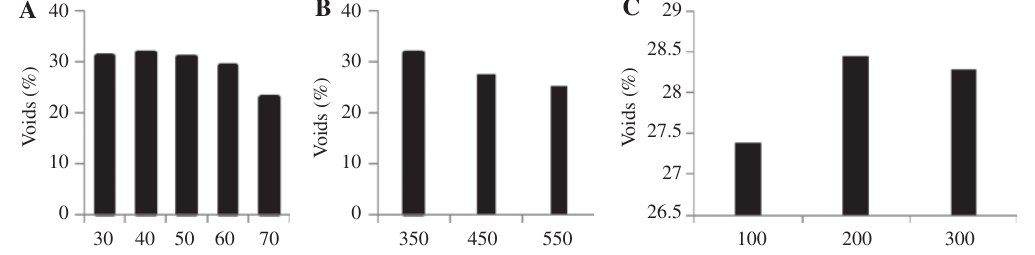
Figure 7: Void content of the composites. (A) PP fibre content (%), (B) areal weight (g/m 2 ), (C) needle density (punches/cm 2 ).